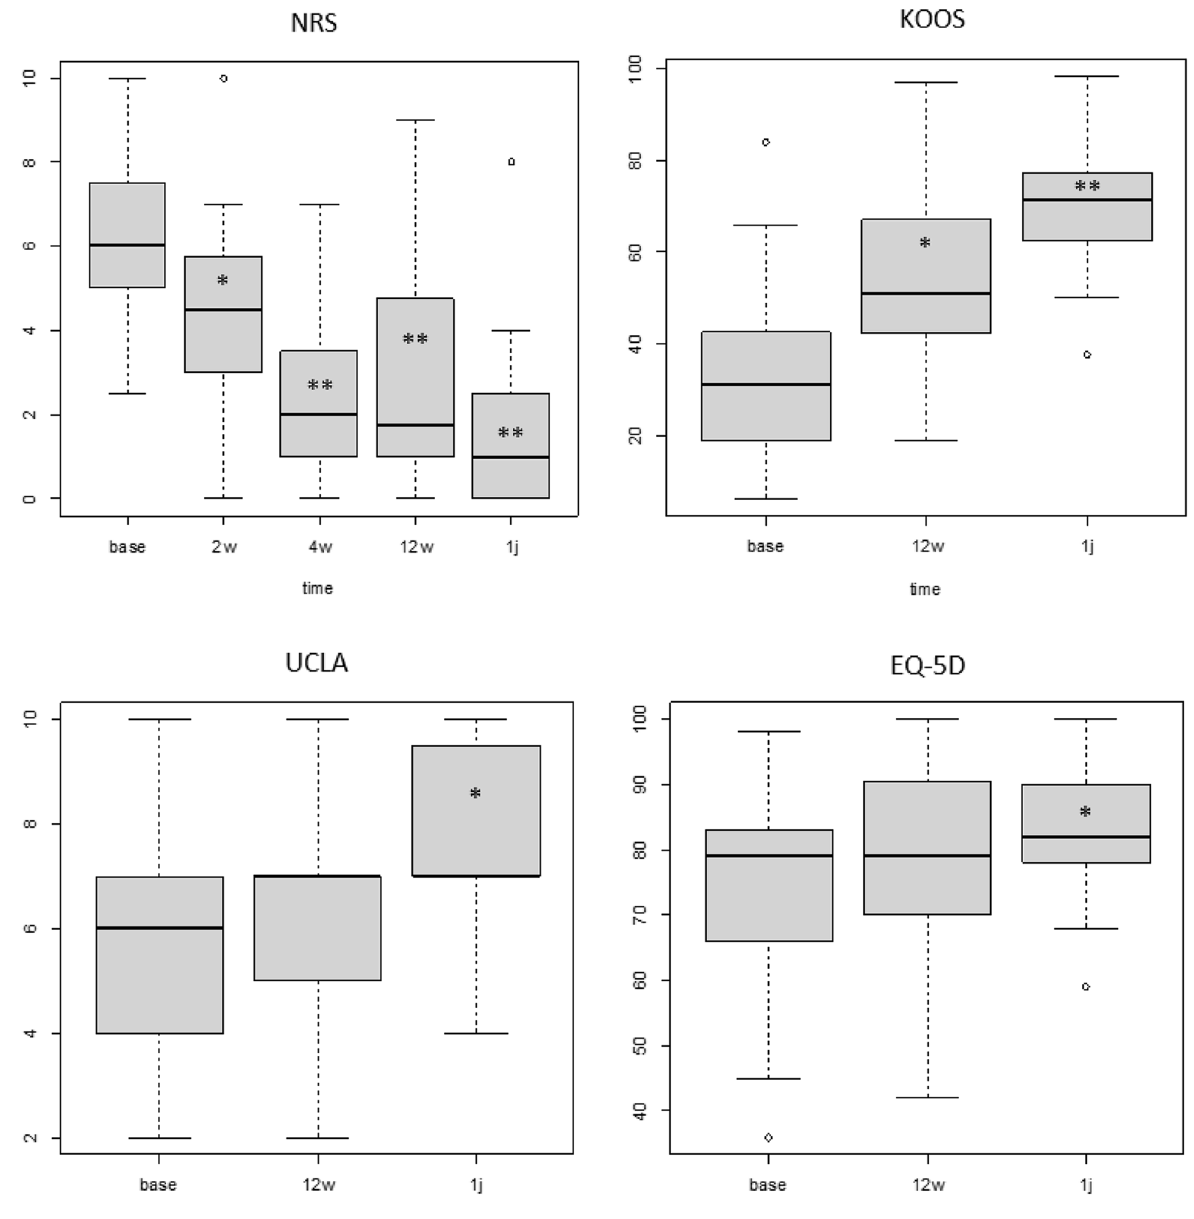
Fig. 6 The Numeric Rating Scale (NRS), KOOS, UCLA and EQ-5D outcomes up to one year after surgery. (*significant difference compared to baseline; **significant difference compared to baseline and first postoperative